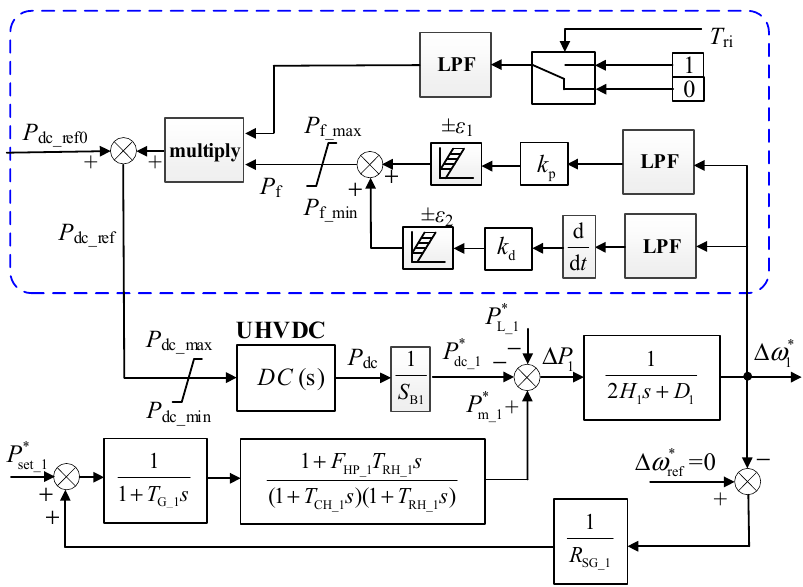
Figure 3. Frequency coordinated control strategy for UHVDC power transmission system.